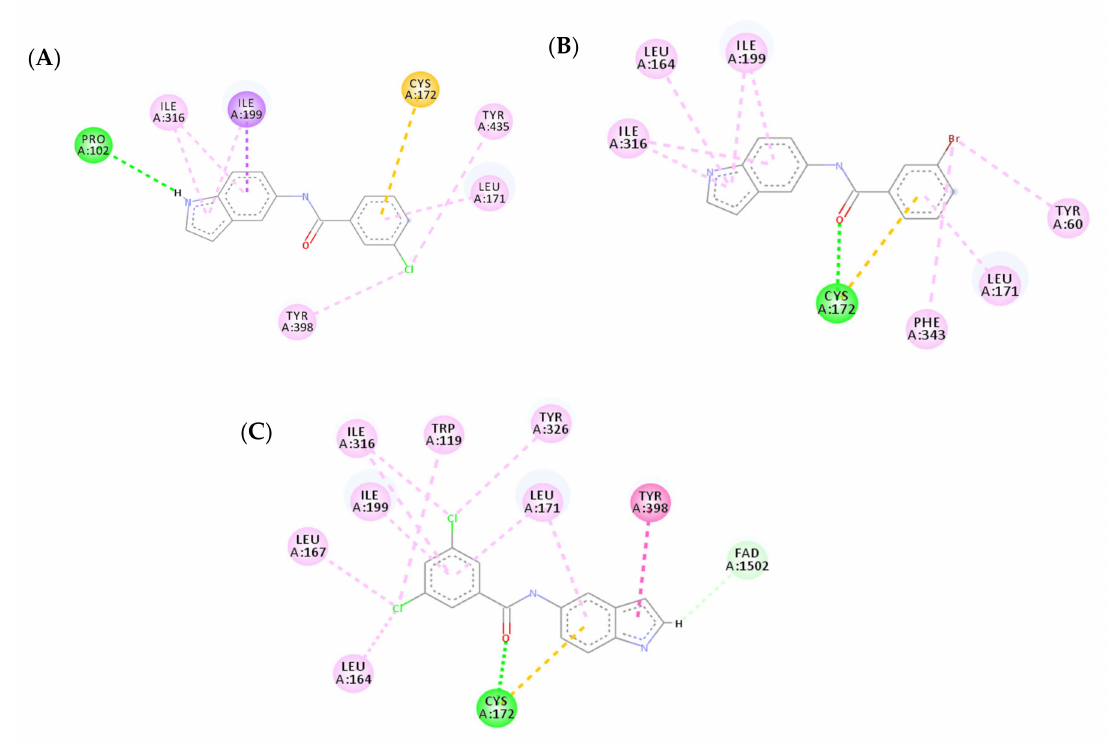
Figure 7. Two-dimensional (2D) interaction models of compounds 3n ( A ), 3r ( B ), and 3w ( C ) with